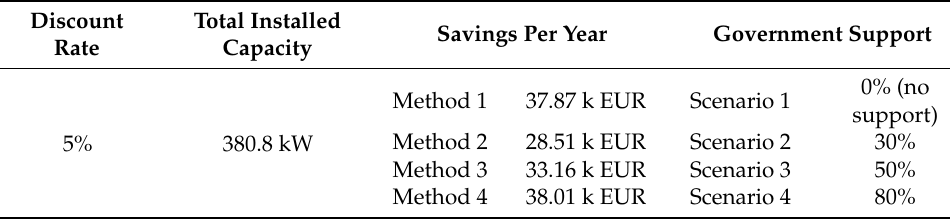
Table 3. Key assumptions for the economic and financial